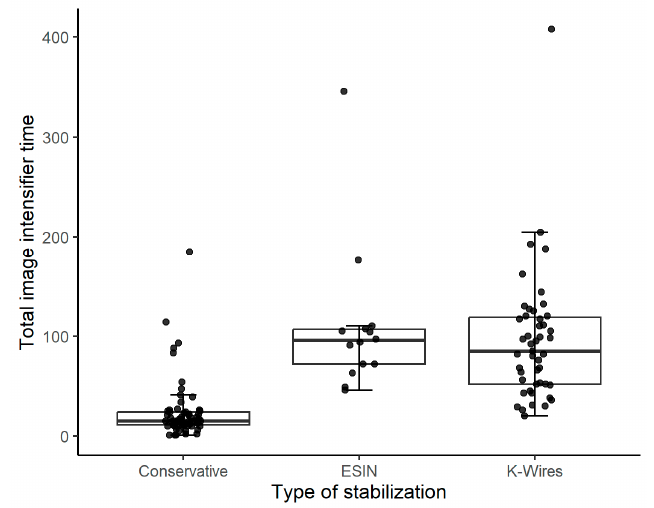
Figure 4. Total time of exposure to image intensifier radiation relative to the type of treatment (n =